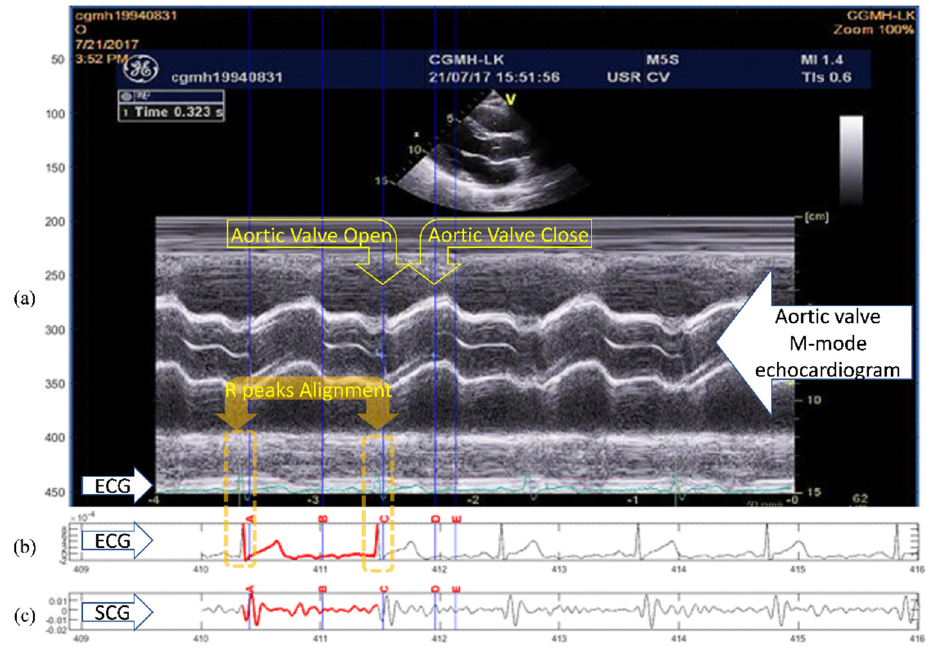
Figure 1. Example of the quasi-synchronous alignment for an echocardiogram image and an SCG measurement: ( a ) M-mode echocardiogram image of the aortic valve (with an ECG signal at the bottom of the image); ( b ) ECG signal simultaneously measured with SCG signal; ( c ) SCG signal.